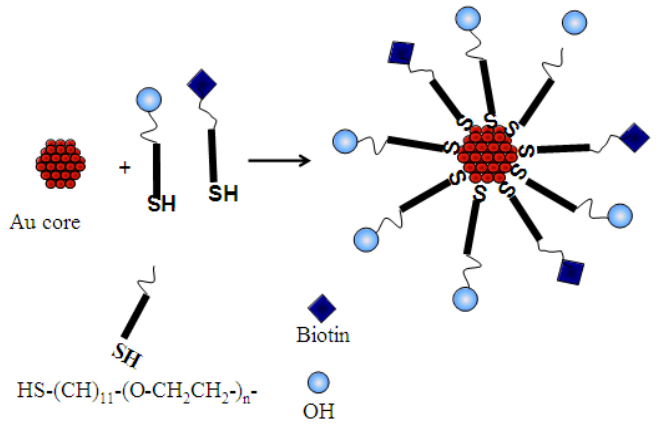
Figure 1. ( a ) UV-vis spectrum of 14 nm AuNPs and ( b ) Transmission Electron Microscopy (TEM) image (100 nm scale) of 14 nm AuNPs.